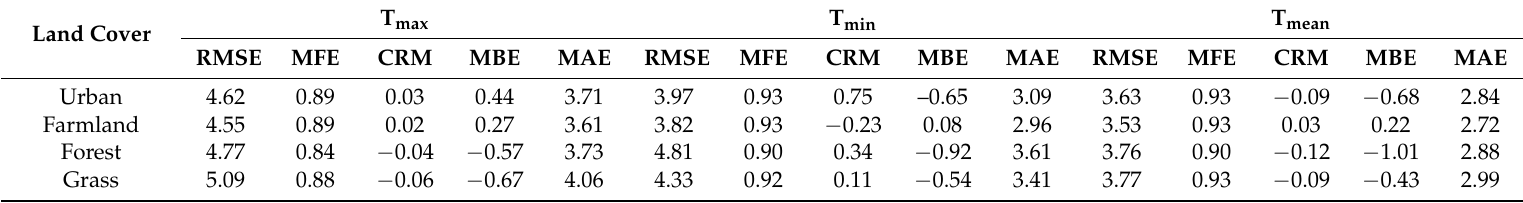
Table 3. The performance of optimal models for T max , T min , and T mean for different land cover types. Model accuracy is given by RMSE, MEF, CRM, MAE, and MBE. Land Cover